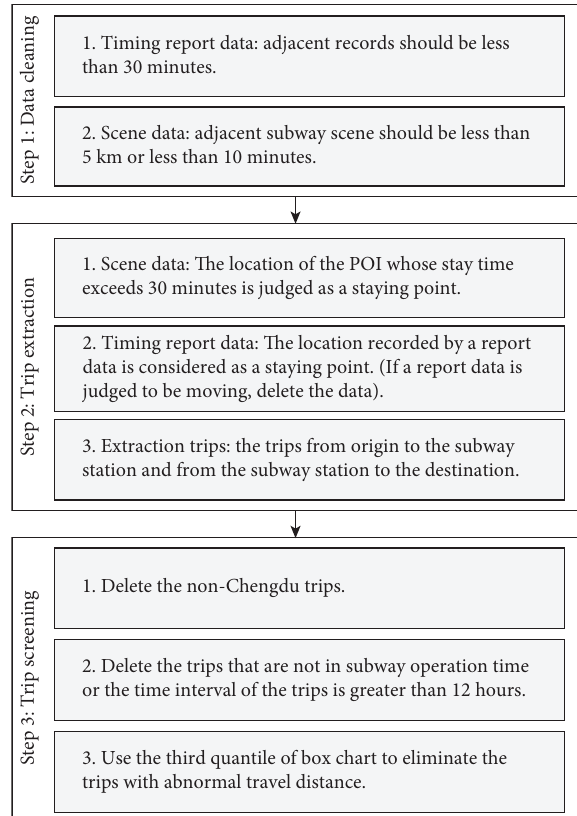
Figure 2: Te extraction process of access and egress